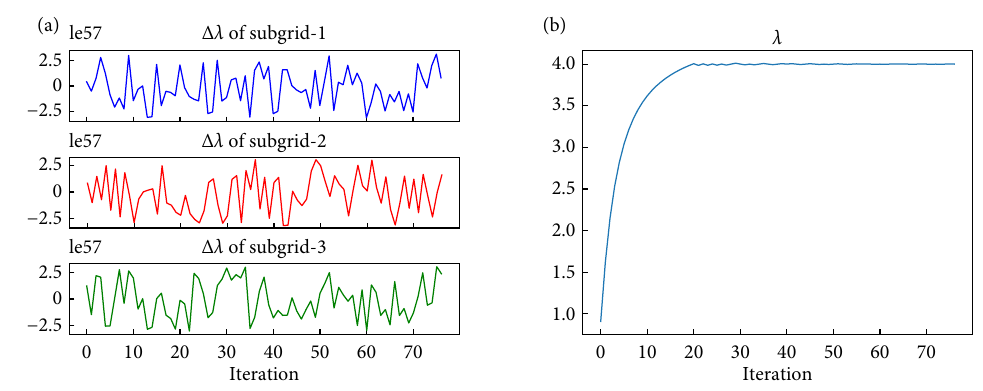
Δλ Fig. 9 The convergence performance of multipliers: (a) shared value of among subgrids, and (b) real value of λ .